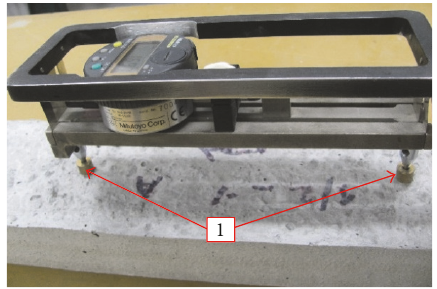
Figure 3: A Hollan strain gauge (1: embedded